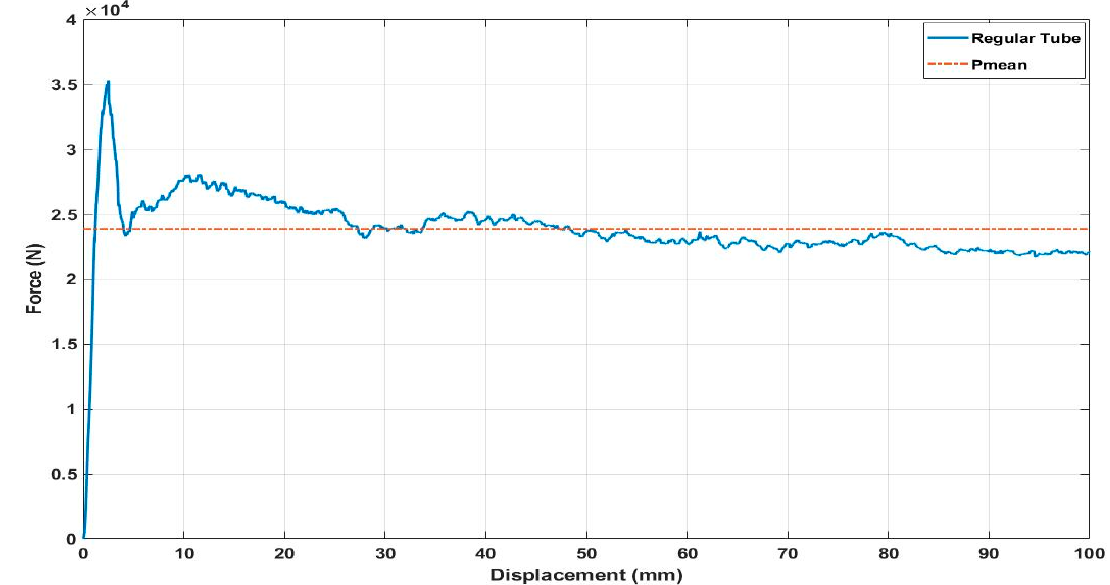
Figure 6. Average force–displacement experimental curve (blue) for the regular tube. The red line represents P mean line for the entire load–deflection response (100 mm of deflection).